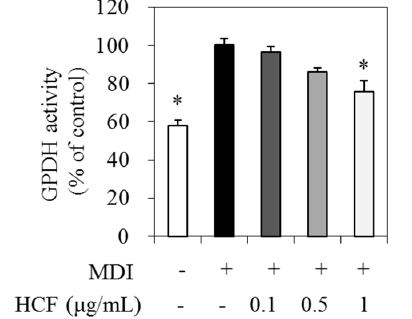
Figure 4. Effects of HCF on GPDH activity in adipocytes. The 3T3-L1 cells were treated with 0 (MDI— treated control, MDI +), 0.1, 0.5, or 1 µg/mL HCF for 7 days. Preadipocytes without MDI media (MDI -) were used for baseline. GPDH activity was determined using a GPDH assay kit. GPDH, glycerol-3-phosphate dehydrogenase; HCF, hot water extract of C. morifolium flower; MDI, medium containing 3-Isobutyl-1-methylxanthine, dexamethasone, and insulin. Values are expressed as a mean ± standard error of three independent experiments. * p < 0.05 vs. MDI—treated control.